Question: Briefly state, in one sentence, what is plotted here.
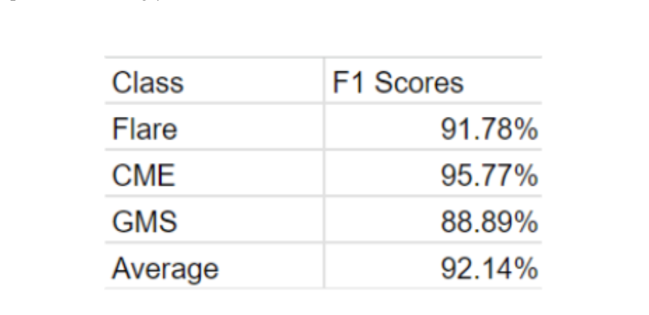
Answer: Table presenting F1 Scores of the model in each class. The model performed strongly in each of these categories.